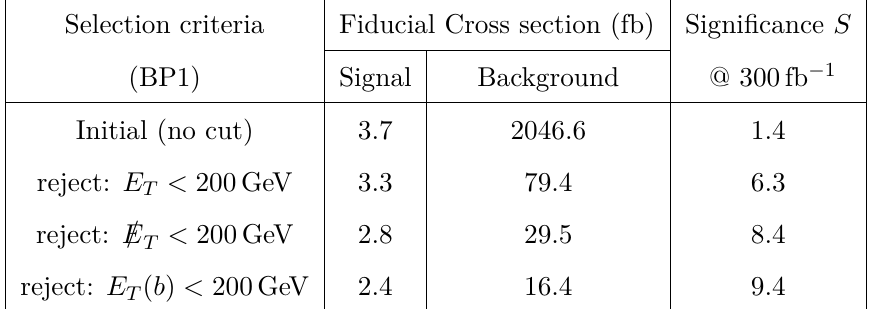
H 0 /A 1 A 1 ) and the SM back- 1 1